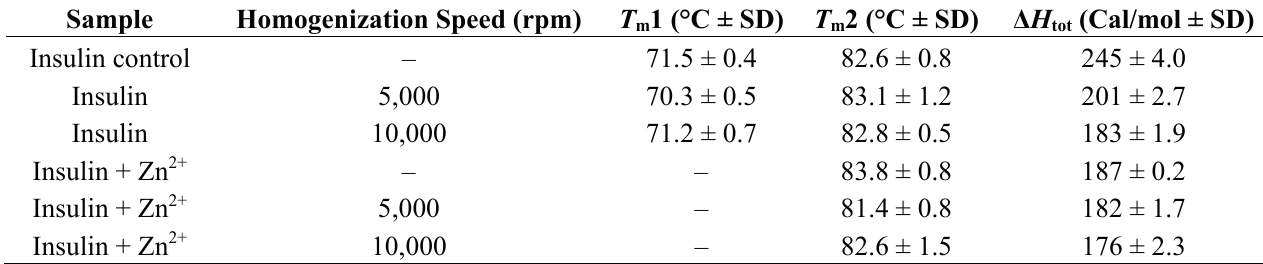
Table 3. Thermal parameters of recovered insulin after emulsification with methylene chloride in the absence of PLGA ( n =